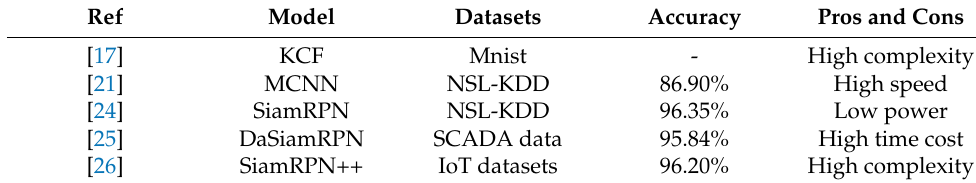
Table 1. Algorithm